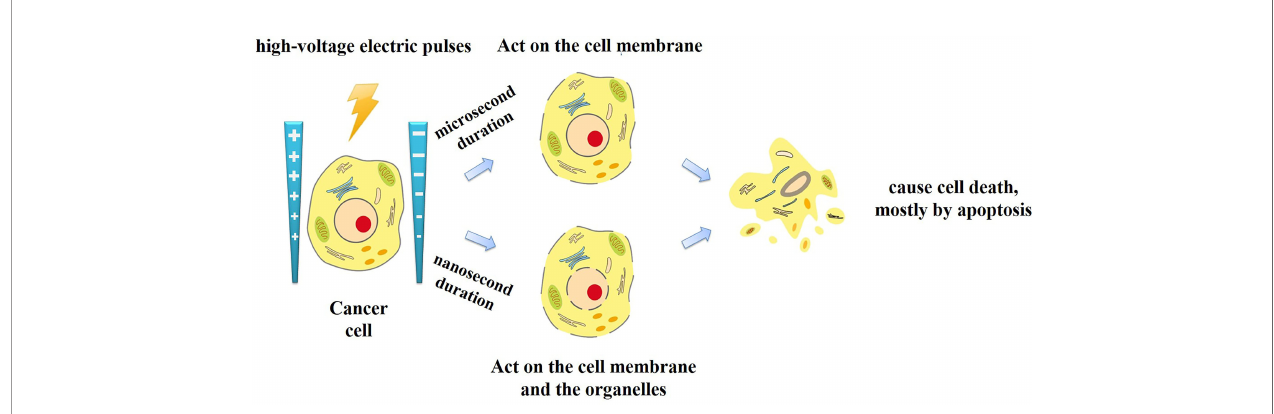
FIGURE 1 | The mechanisms of high-voltage electric pulses with microsecond or nanosecond